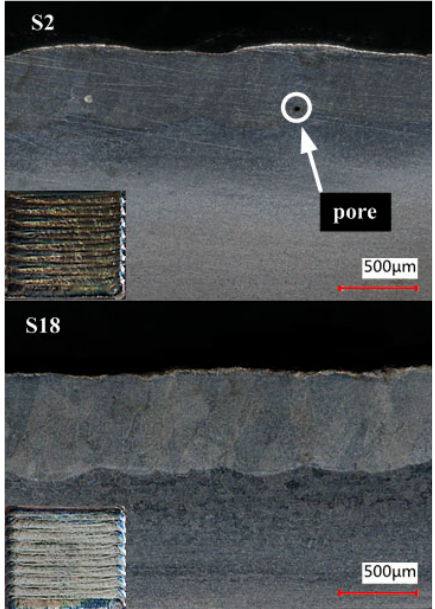
Figure 7. Comparison of the cross ‐ sectional morphology of the molten cladding layer of S2 and